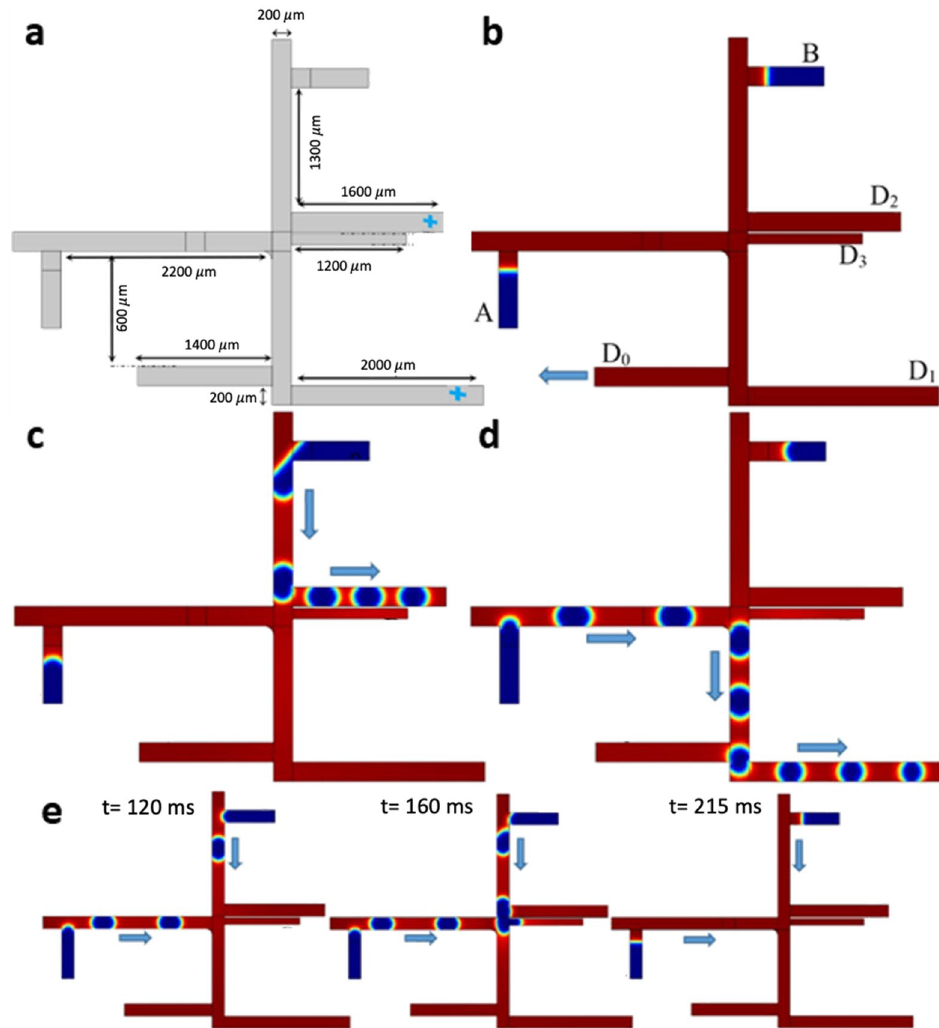
Figure 11. The microfluidic architecture of Decoder 2 to 4. (a) The design and geometry of the fluidic network for Decoder 2 to 4. (b) A snapshot of the logic condition A = 0, B = 0 , wherein the carrier flows toward output D 0 . (c) A snapshot of the logic condition A = 0, B = 1 , wherein the bubbles flow toward output D 2 . (d) A snapshot of the logic condition A = 1, B = 0 , wherein the bubbles flow toward output D 1 . (e) Series of snapshots of the logic condition A = 1, B = 1 , wherein the bubbles flow toward output D 3